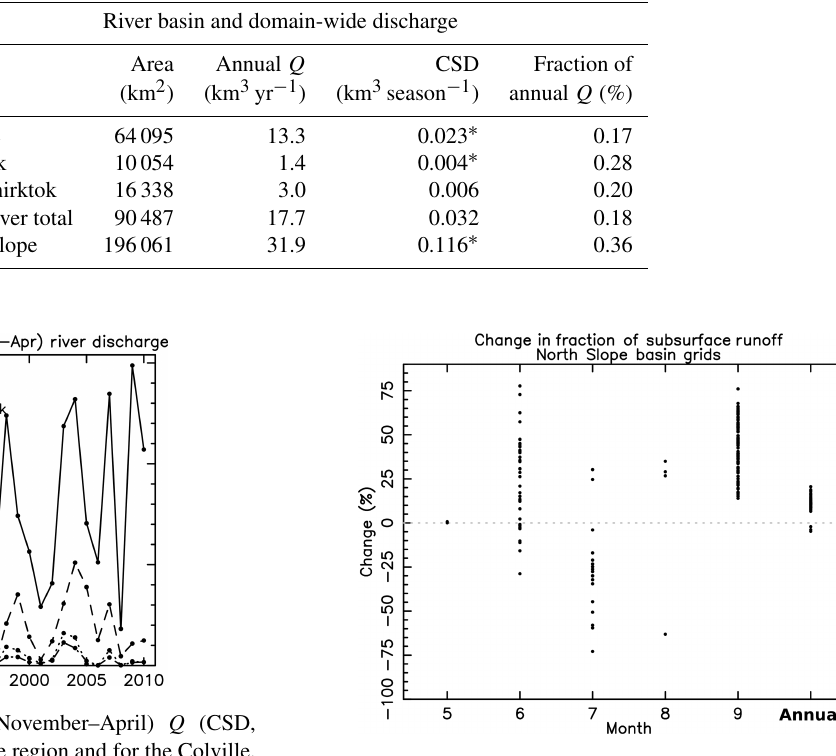
Figure 7. (a) Grid cell change in fraction of subsurface R ( F sub ) for warm season months May–September and for annual total F sub and R . F sub changes are not defined for other months due to F sub being consistently at 100%, or the grid cell having no runoff for that month in more than 50% (15 of 30) of the data years. Change is expressed with respect to the long-term average. Dots represent grid cells that show a significant change at p < 0 . 05. Average for grids with a significant change at the annual scale is + 11 .